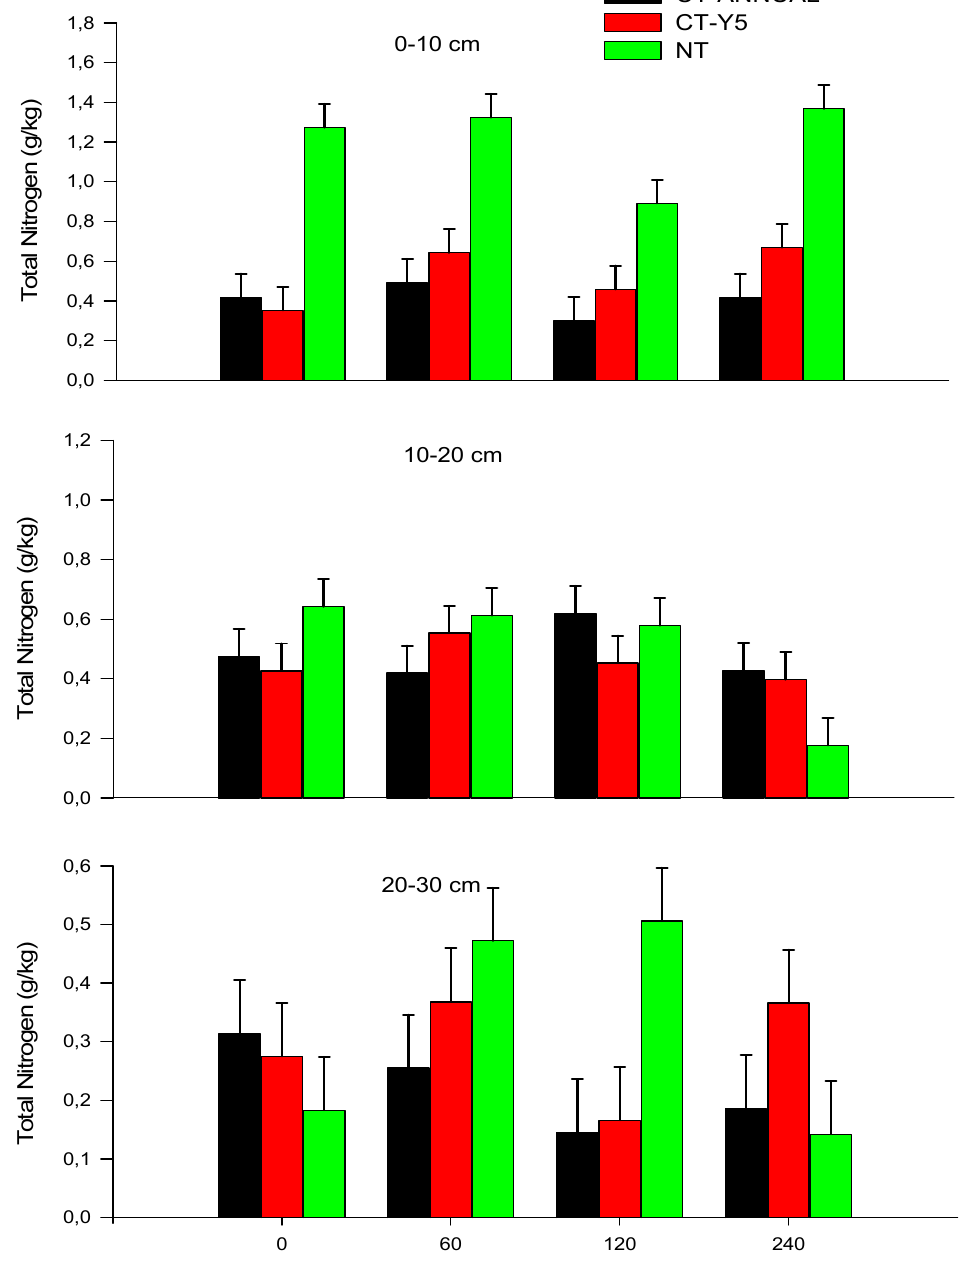
Figure 1. Contents of total N according to depth under different tillage techniques and urea fertilizer application